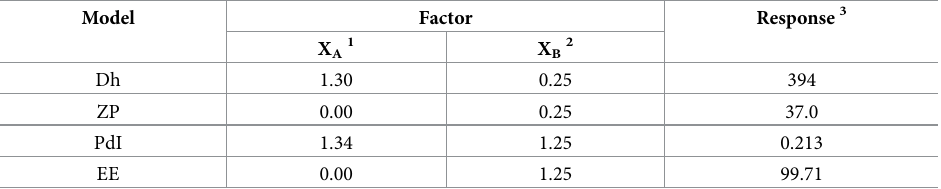
Table 4. Values of the factors that optimise each response and the corresponding predicted optimal response